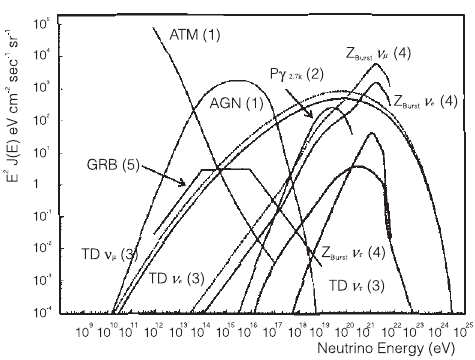
Fig. 4. Predicted neutrino fl uxes for various models. The large range of predicted fl uxes should be noted as should the number of models which exceeds the number of events with energies > 10 20 eV! (1) Stecker and Salamon (1996); (2) Stecker et al. (1991); (3) Sigl et al. (1999), m = 10 16 GeV, X - > q + q , supersymmetric X fragmentation; (4) Yoshida et al. (1998), m primary F ~ E –1 ; (5) Waxmann and Bachall (1997). n